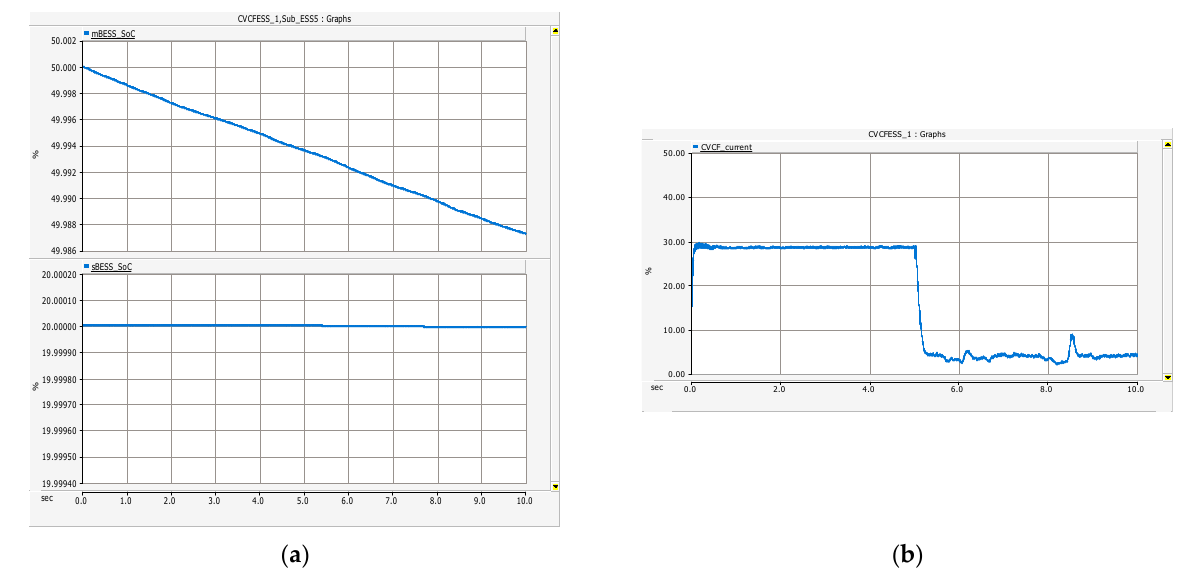
Figure 19. Simulation results of Scenario 2 ( a ) SoC (top: SoC of the mBESS; bottom: SoC of the sBESS) and ( b ) current unbalance rate of the mBESS.